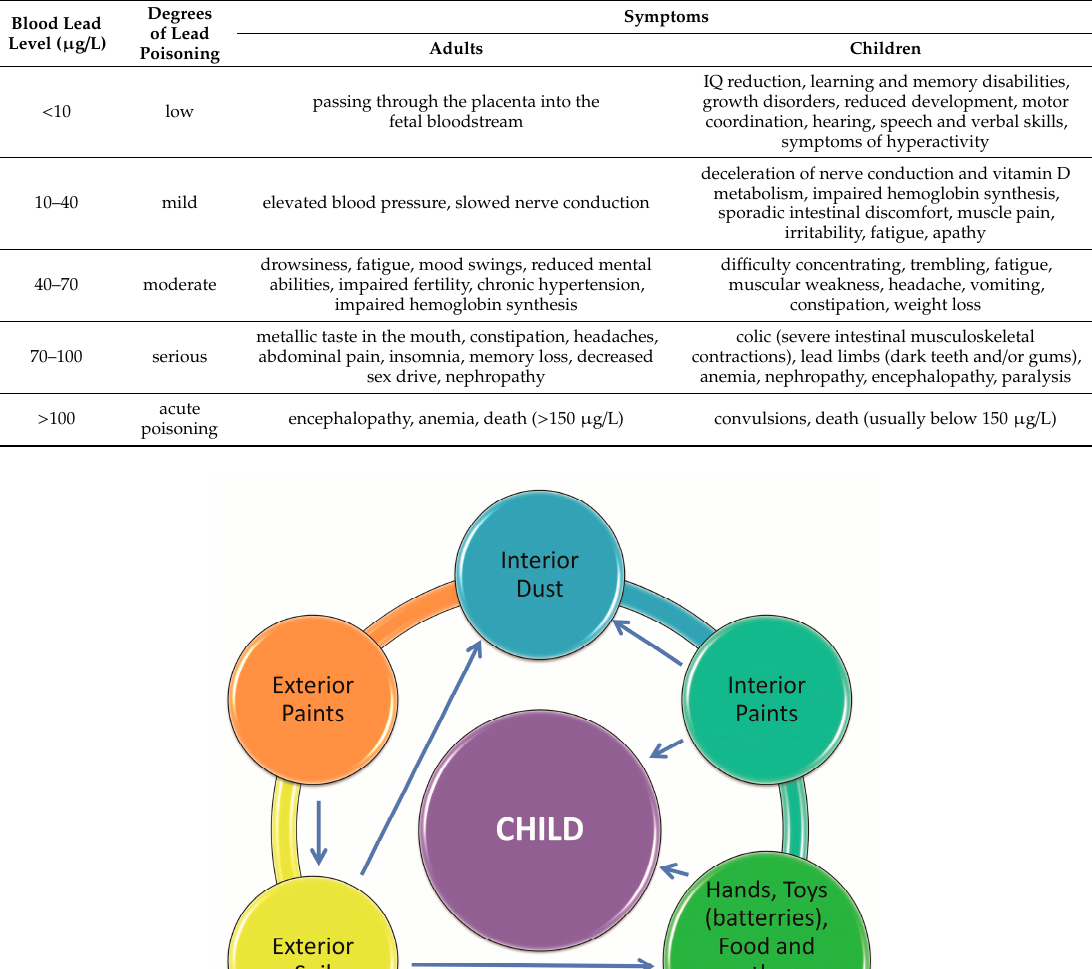
Table 1. Symptoms of poisoning according to the degree of exposure in children and adults (Adopted from [4]).